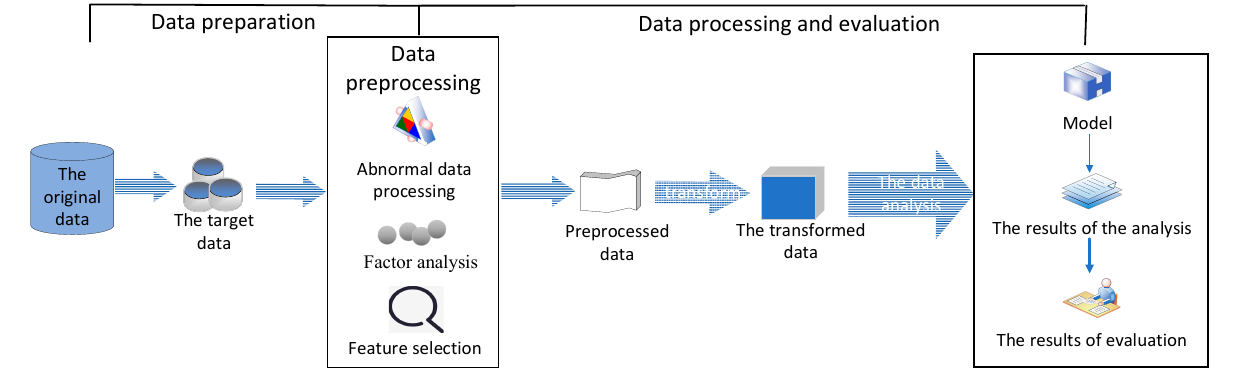
Figure 1. Flow chart of clustering algorithm.